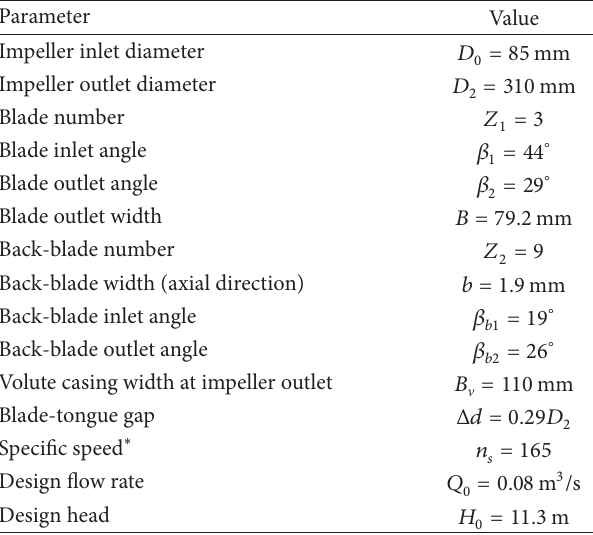
Table 1: Basic parameters of the pump.